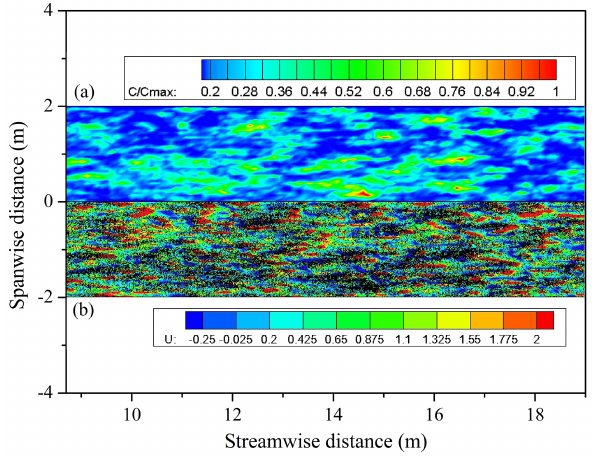
Figure 4. (a) The top view of the sand streamer concentrations, where C represents the particle concentrations, C max represents the maximum particle concentrations. (b) The top view of the whole- particle positions and the streamwise velocity diagram of flow field with the height of 0.005m, where the y coordinates are correspond- ingly shifted down by 2, the black dots represent the sand particles and U represents the streamwise wind speed of the sand-laden flow ( u τ = 0 . 3ms − 1